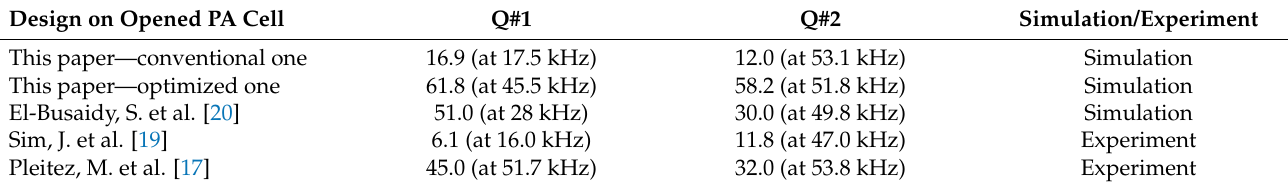
Figure 5. Frequency response of “cardiac-type” and conventional cells. Table 2. A comparison between the Q factor values obtained in this study and previous work.